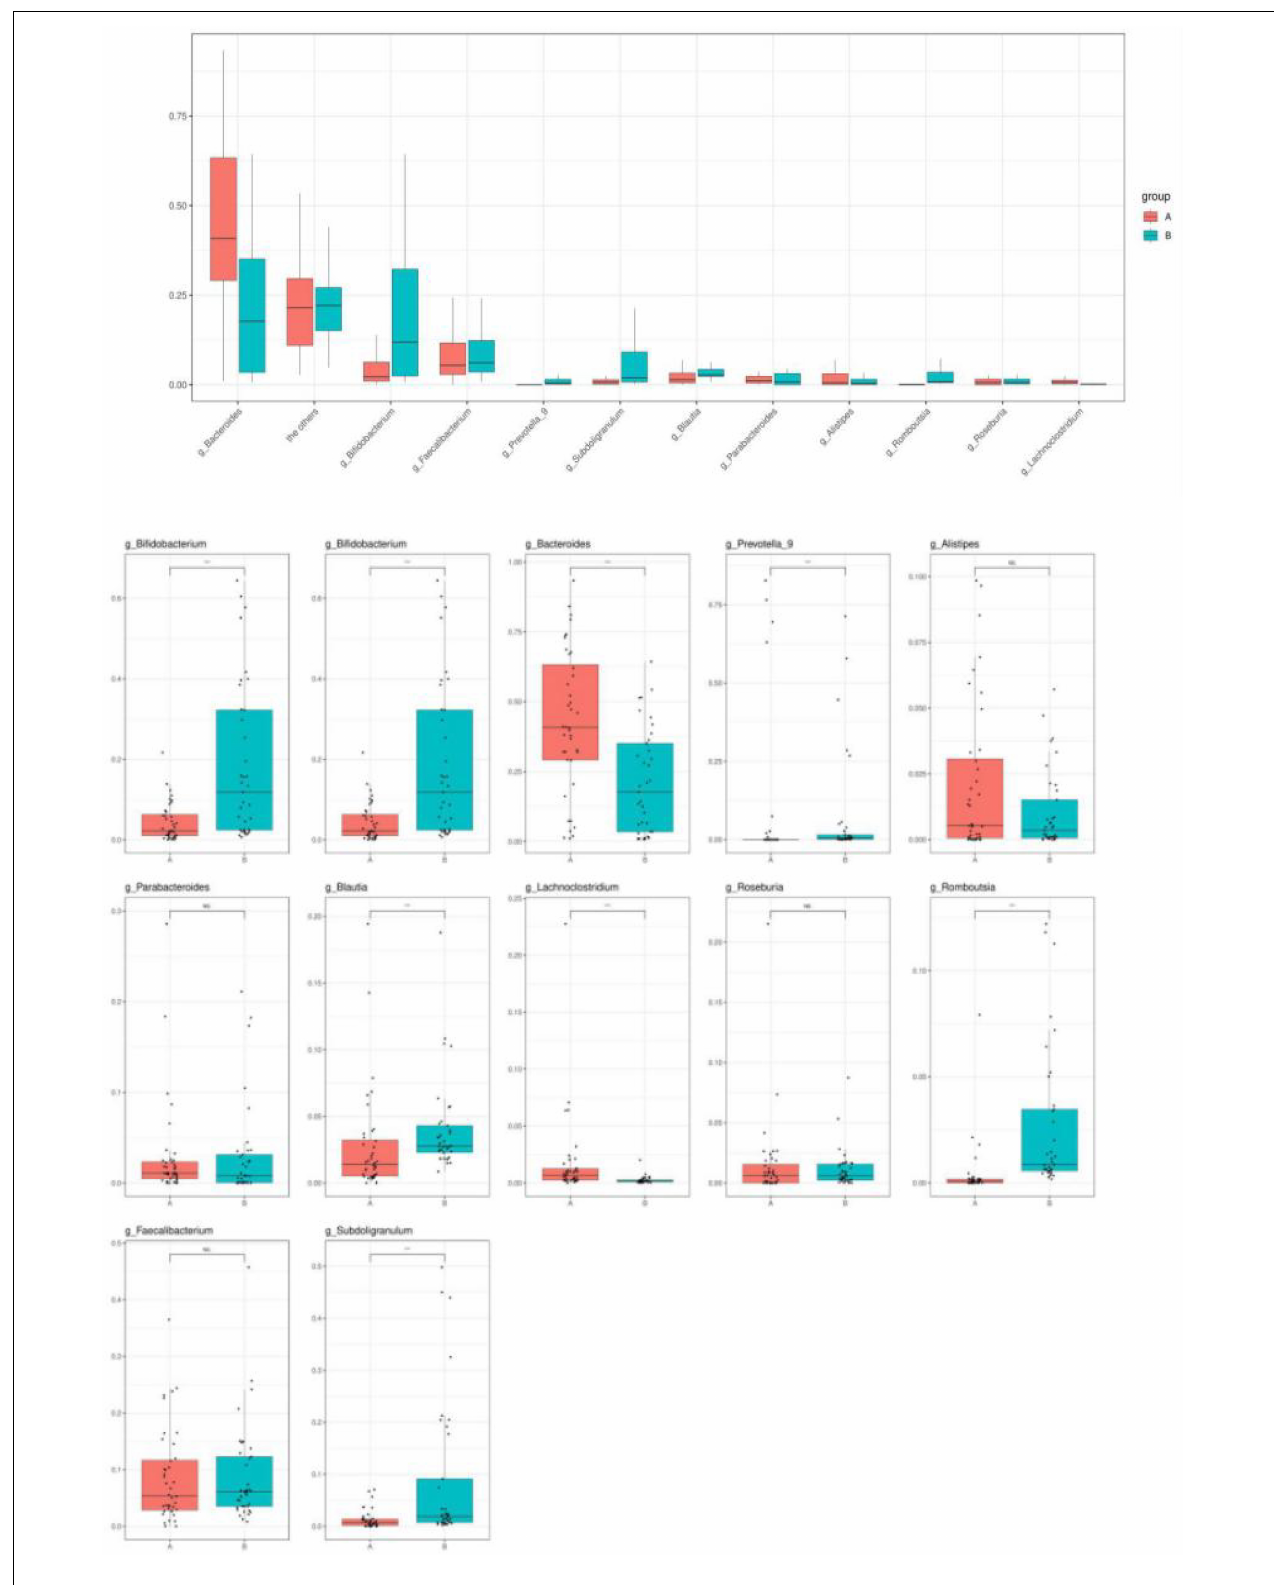
FIGURE 4 | Species with abundance greater than 0.1% at the genus